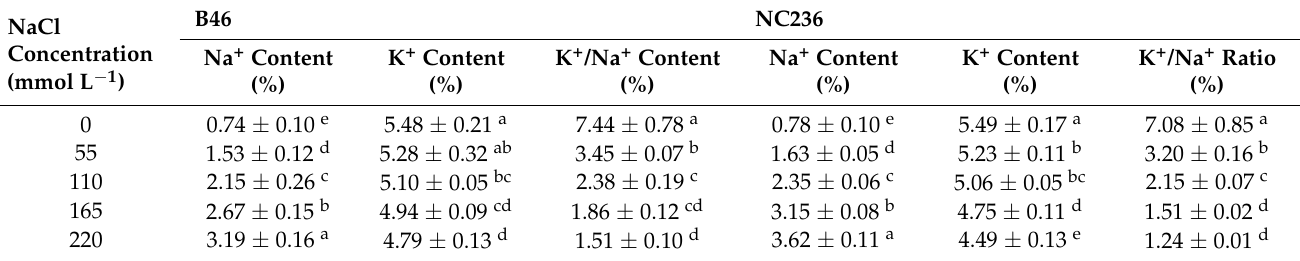
Table 1. Effects of salt stress on the contents of Na + , K + , and K + /Na + ratio in maize leaves.